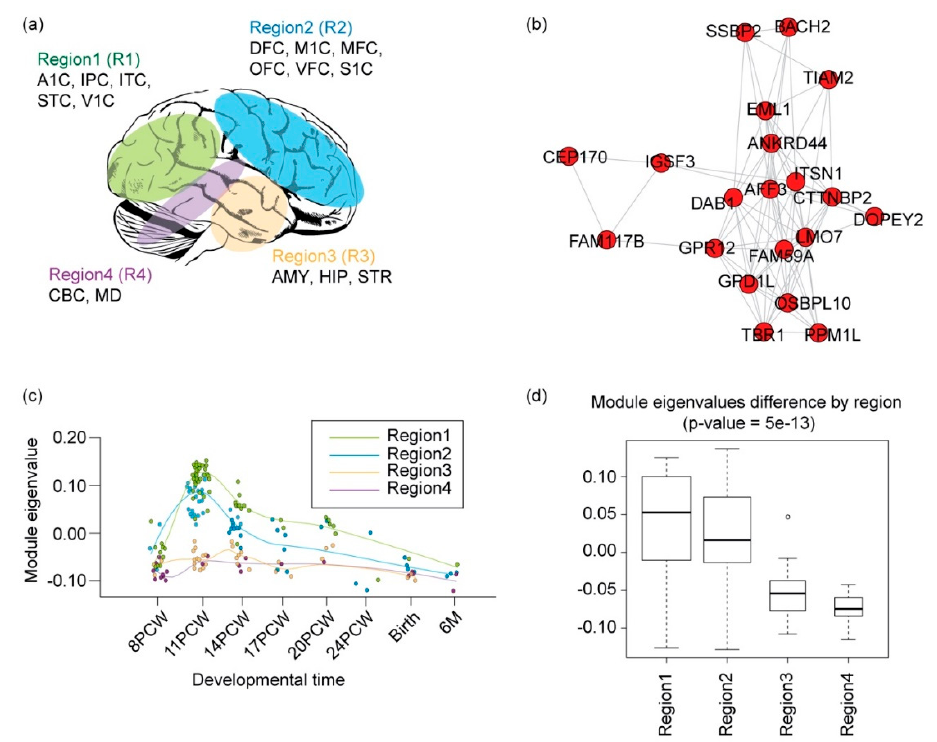
Figure 5. Functional convergence of rare coding and regulatory variants in the mid-fetal neocortex. ( a ) An anatomical selection for WGCNA. Shown are four brain regions grouped according to similarity of gene expression pattern (Willsey et al. 2013) [3]. ( b ) Network of co-expressed gene module 14, including genes involved in ionotropic glutamate receptor signaling (GO:0035235) and generation of neurons (GO:0048699). ( c ) Eigenvalues of gene modules through development. The circles represent the samples from each region. Regions include four regional groups from Figure 5a, and use the same color code for a regional group. The x -axis indicates the developmental time, and the y -axis indicates the module eigenvalue of the samples for each developmental time. PCW: post-conception weeks; M: months. ( d ) Eigenvalues of the gene modules across the four brain regions.